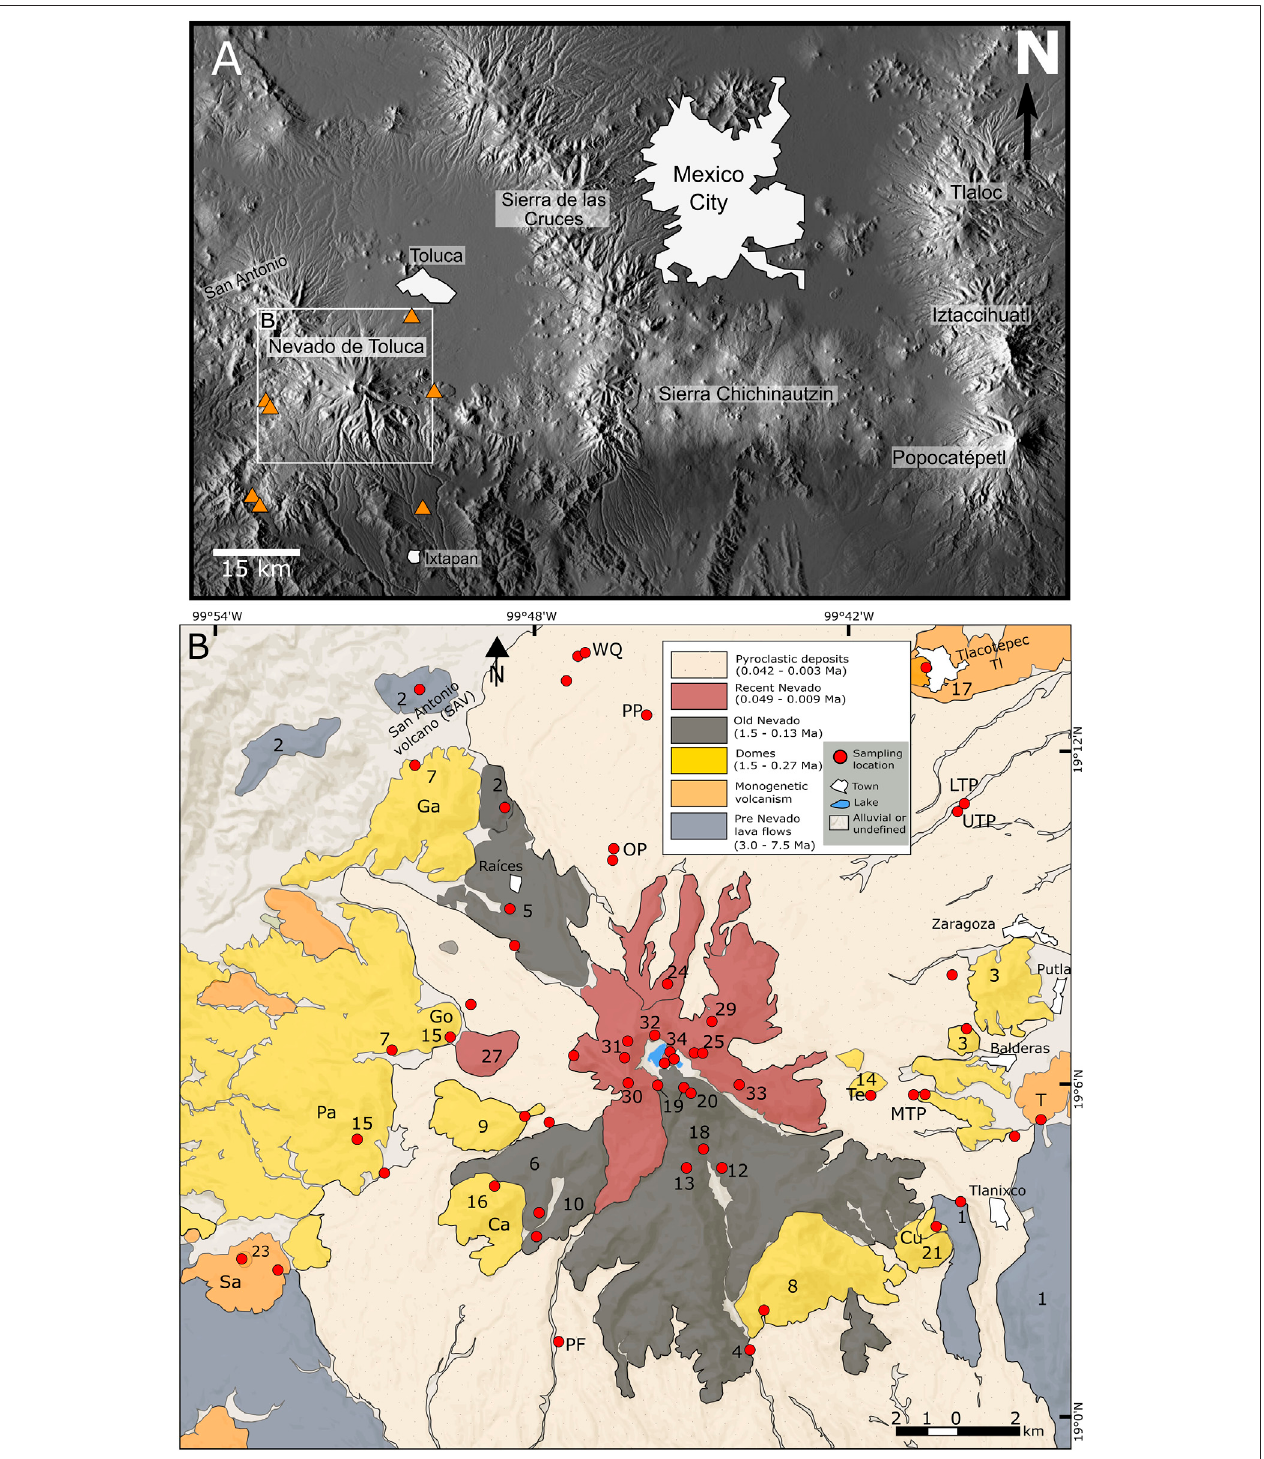
FIGURE 2 | Relief, geological map and sampling locations. (A) Shaded relief of the Lerma basin and valley of Mexico with major volcanic structures indicated by labels. The location of major cities is marked by white areas. Sampled monogenetic cones in the greater Nevado de Toluca area are shown by orange triangles. (B) Geological map of Nevado de Toluca modi fi ed from Torres-Orozco et al. (2017). The map is divided into 6 major groups: Pre-Nevado lava fl ows (gray), Monogenetic volcanism (orange), Domes (gold), Old Nevado stage (darkbrown), Recent Nevado stage (red), and Young Pyroclastic deposits (beige). Sampling locations are indicatedbyred dots andnumbers indicate thesampledunit. Calotepec dome (Ca), Cuescontepec(Cu), LaGalera(Ga),Cerro Gordo (Go),Lower Toluca Pumice(LTP), Middle Toluca Pumice (MTP), Ochre Pumice (OP), Las Palomas (Pa), Pyroclastic Flow 970 (PF), Pink Pumice (PP), Sabanillas (Sa), Tenango (T), Tepehuisco (Te), Tlacotepec cone (Tl), Upper Toluca Pumice (UTP), White Quarry (WQ).